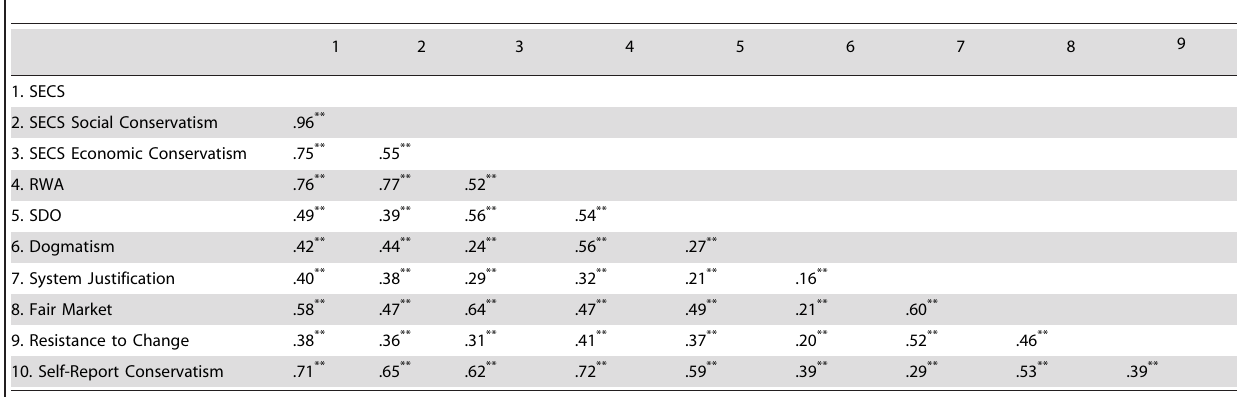
Table 6. Correlation Matrix to show the relationships between scores on SECS and other